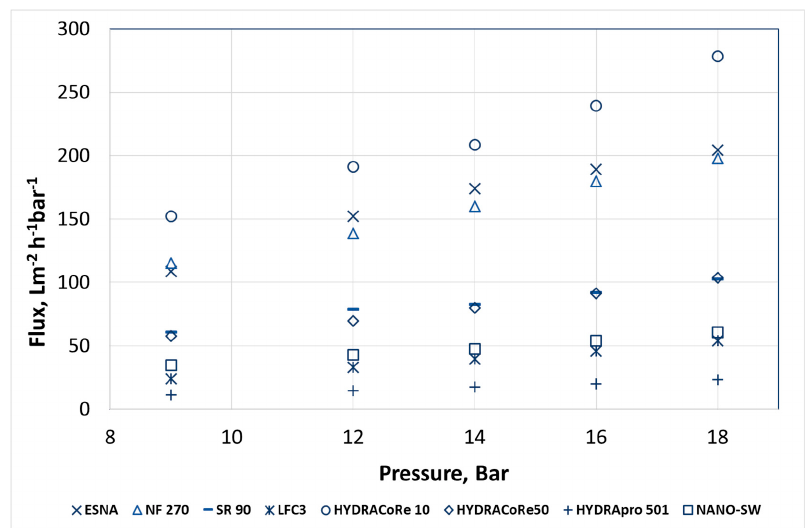
Figure 1. Pure water flux as a function of operating pressure for eight different membranes.